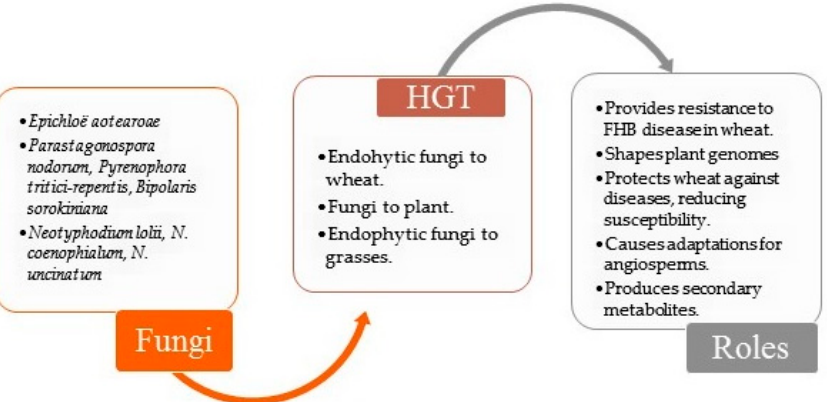
Figure 2. Examples of HGT cases described in plant and fungi endophyte relationships [43,66–75]. FHB—Fusarium head